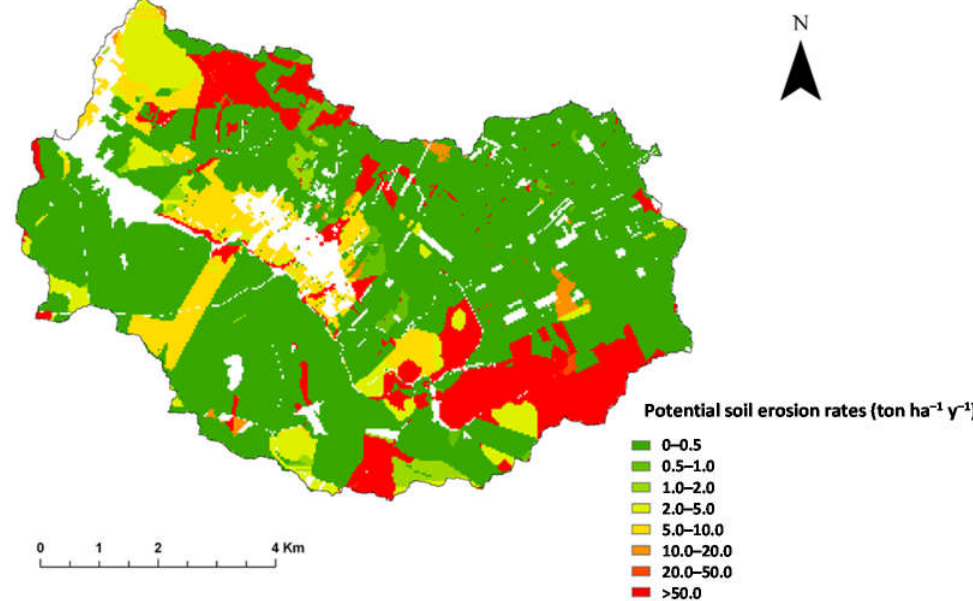
Figure 5. Soil erosion risks in the Enxoé catchment using the PESERA model.